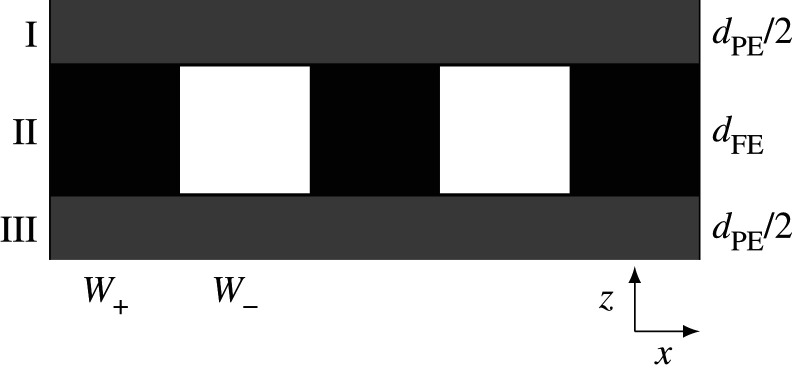
The geometry of a FE/PE superlattice. Regions I and III correspond to half of a paraelectric layer each and region II is the ferroelectric layer. The thicknesses of the layers are indicated on the right and W+ and W− are the widths of the different domain orientations. The black squares are positive domains, with polarization +P and the white squares are negative domains with polarization −P. The system is periodic in the horizontal and vertical directions, with periods W = W+ + W− and D = dFE + dPE, respectively.